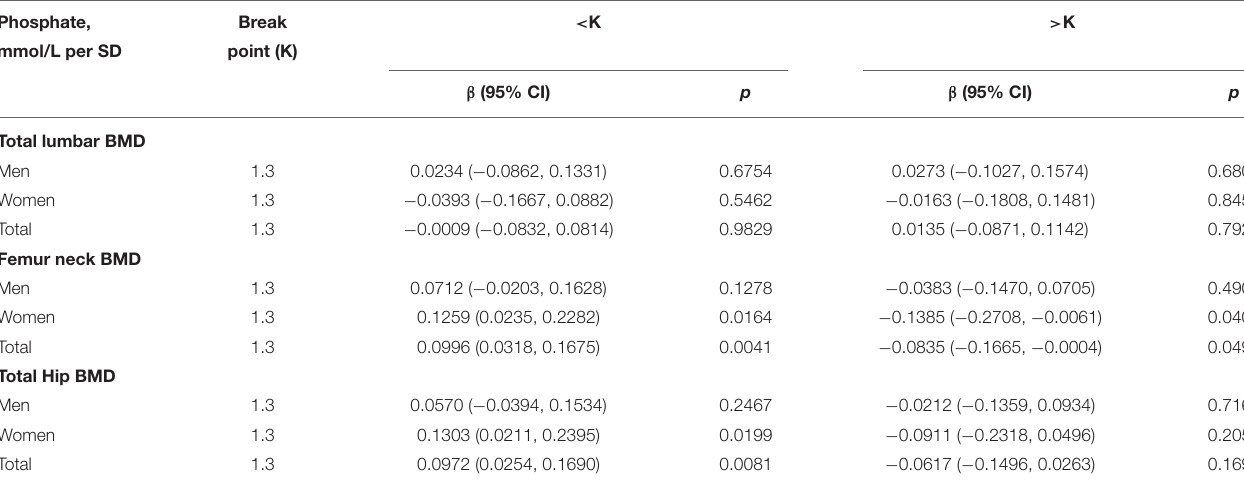
TABLE 3 | Non-linear association between serum phosphate level and BMD. Phosphate, Break < K >